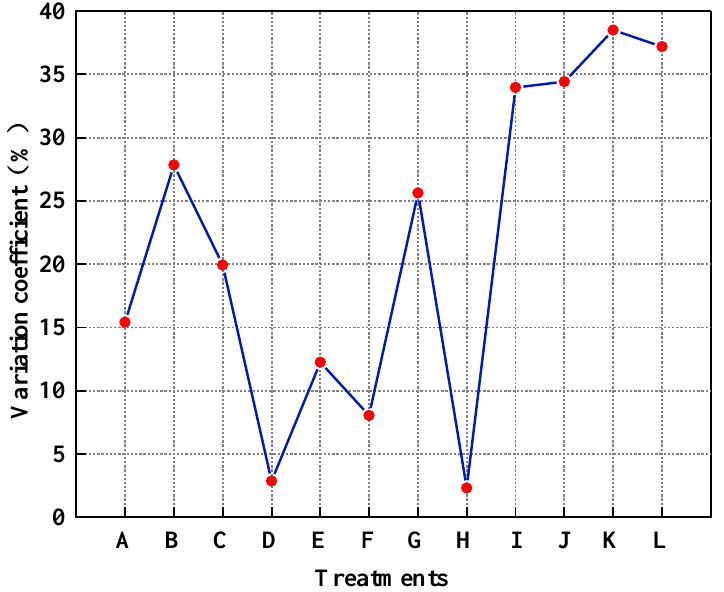
Figure 12. CV distribution of droplet deposition under different experimental treatments.